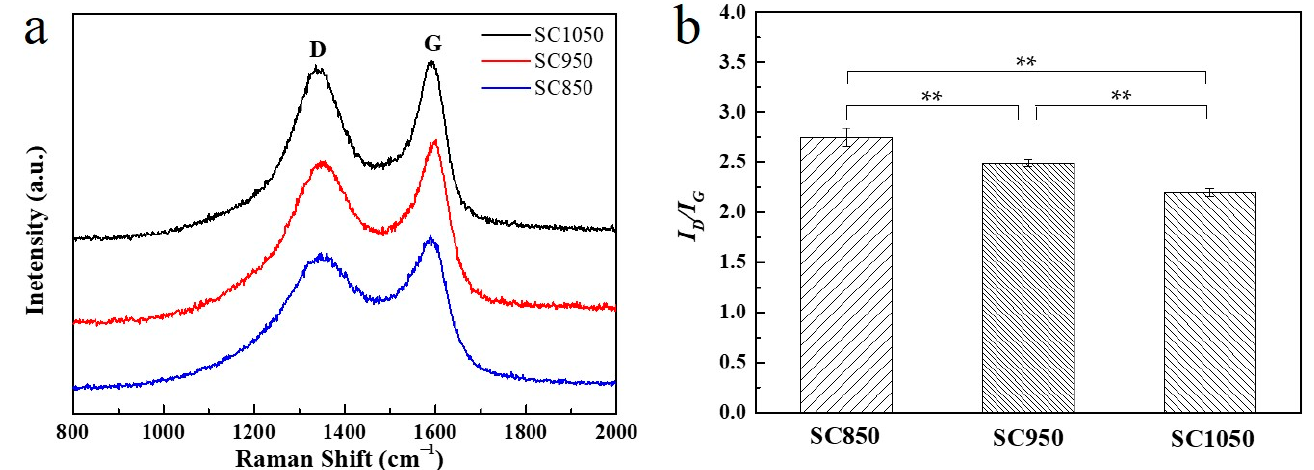
Figure 5. ( a ) Raman spectra and ( b ) calculated I D /I G values for samples SC850, SC950 and SC1050. (n = 3, ** p < 0.01).